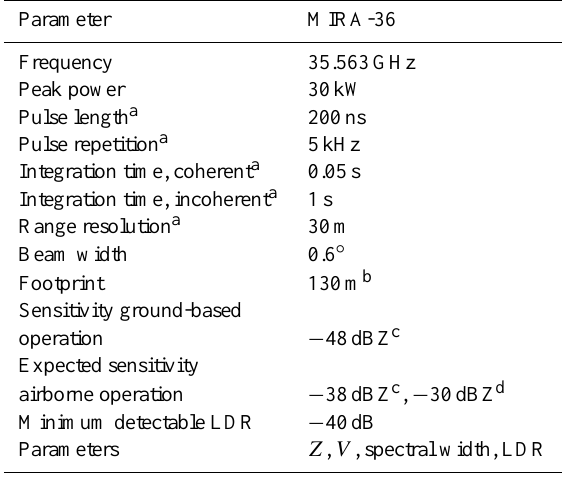
Table 1. Specifications of the cloud radar MIRA-36 as a component of